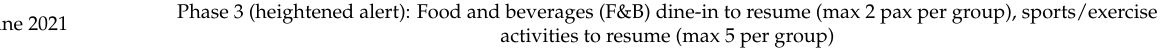
Table A1. Timeline of main changes in Singapore through the 1-year period between the 2nd and 3rd surveys (1–28 June